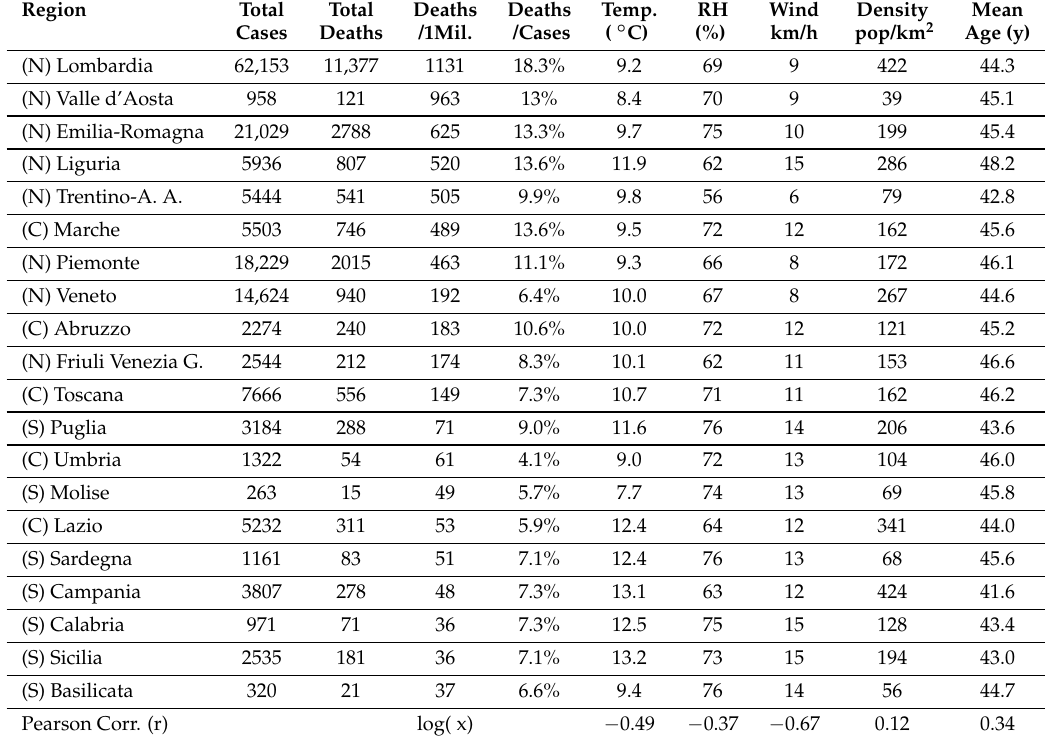
Table 3. Total cases and deaths, deaths per million people, deaths per cases and weather means for March 2020 for each Italian region. Regional population density and mean age are added for comparison. The regions are ranked by the number of deaths per million people. (N) Northern Italy; (C) Central Italy; (S) Southern Italy. The Pearson correlation coefficients are relative to the logarithm of